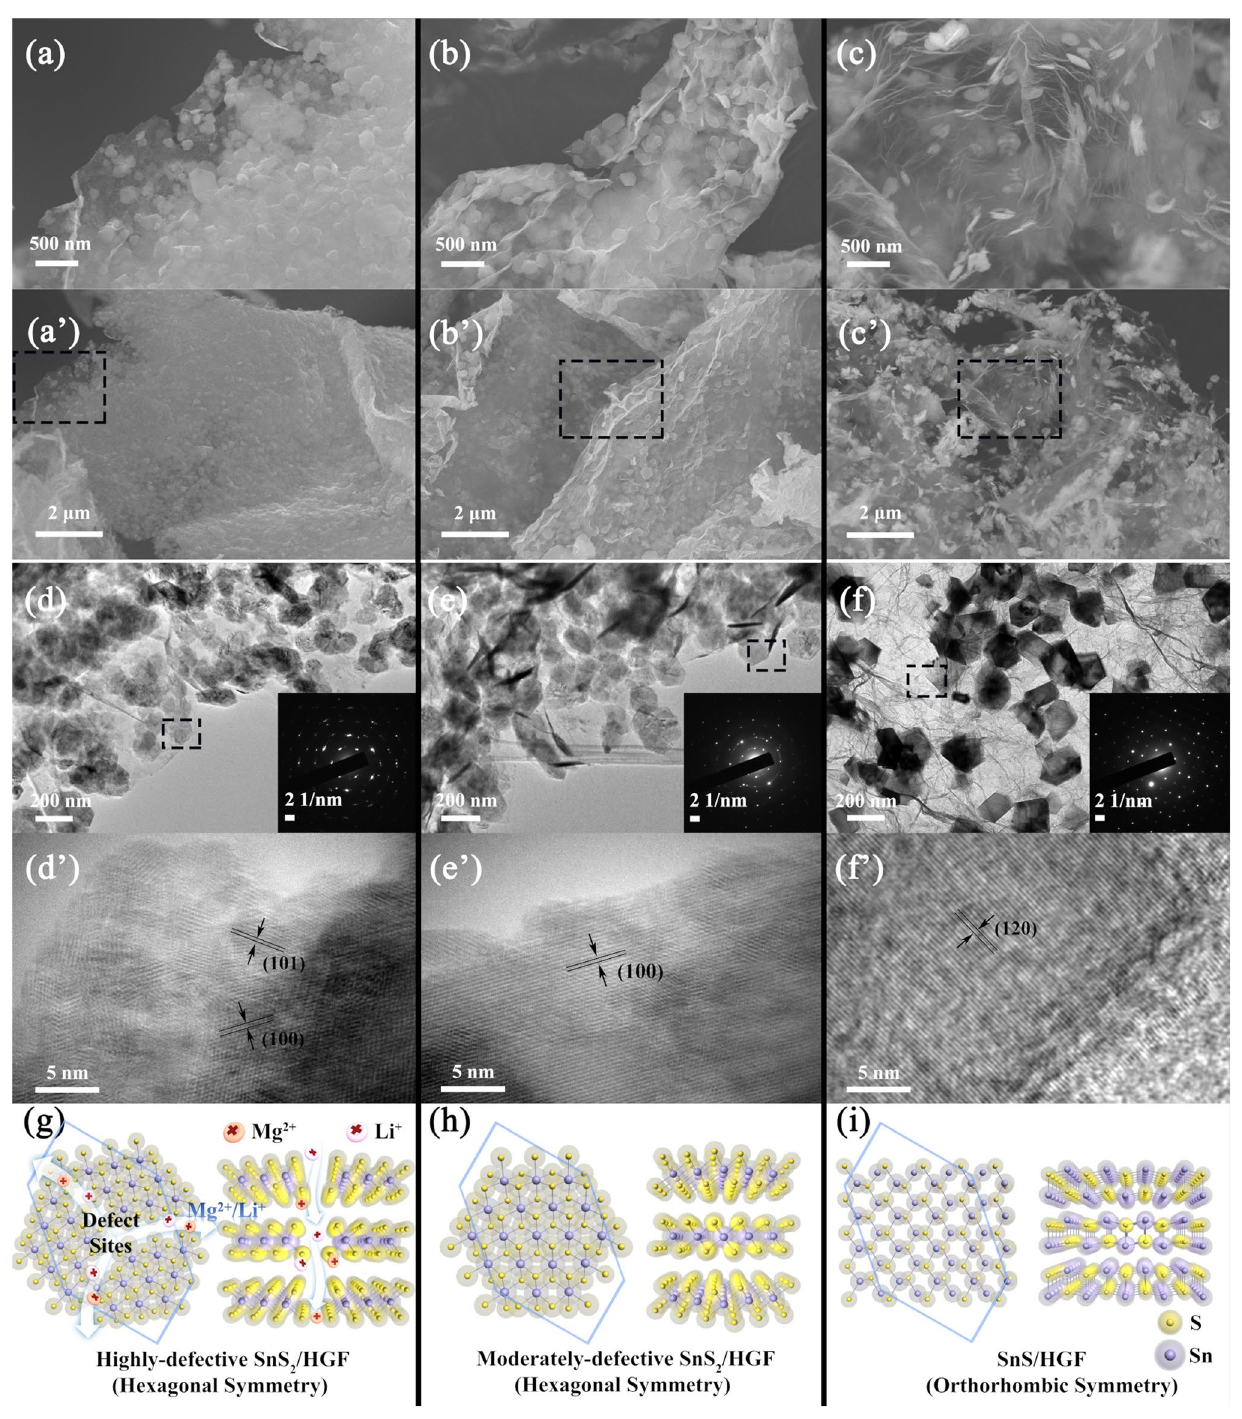
Fig. 2 Morphology analysis of SnS x /HGF. FESEM images of ( a, a’ ) highly defective SnS 2 /HGF, ( b, b’ ) moderately defective SnS 2 /HGF, and ( c, c’ ) defect-free SnS/HGF at different magnifications. The SEM images of HGF and neat SnS x with various magnifications are shown in Figure S1-2. HRTEM images of ( d, d’ ) highly defective SnS 2 /HGF, ( e, e’ ) moderately defective SnS 2 /HGF, and ( f, f’ ) SnS/HGF at different magnifica- tions. Their respective selected area electron diffraction (SEAD) patterns of the samples are shown in the insets. ( g, h, i ) Crystal structures of the different corresponding SnS x /HGF viewed along with the crystallographic c- and